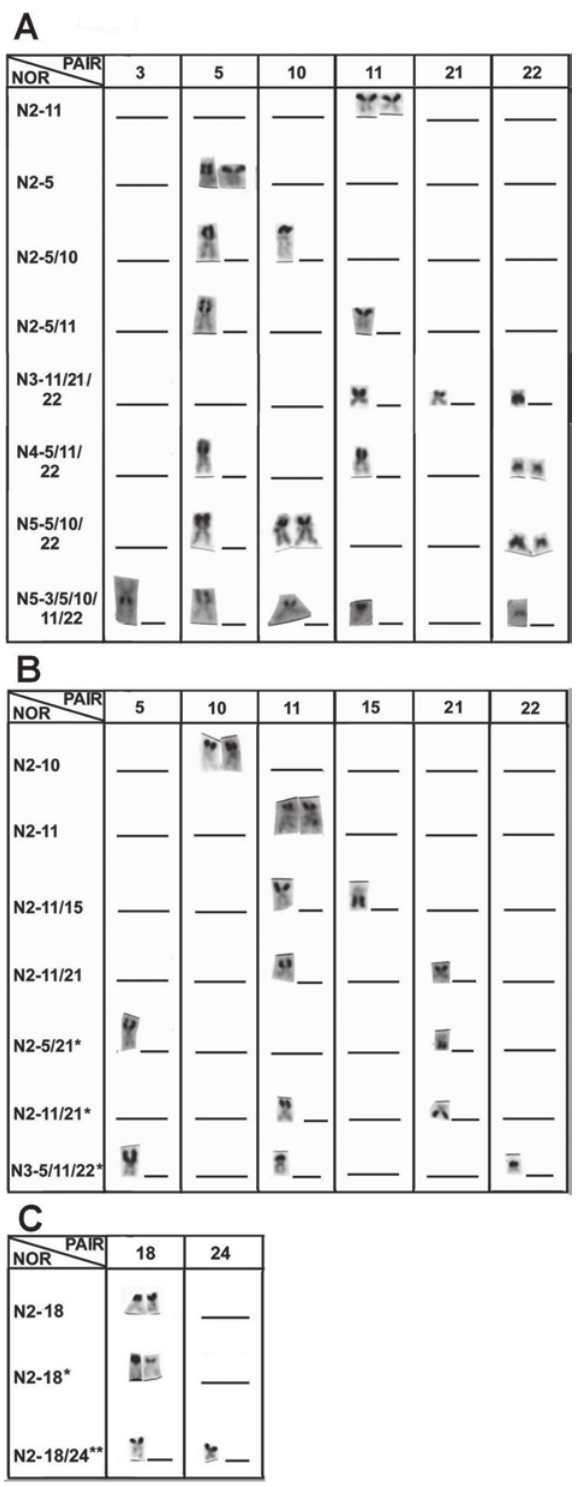
Fig. 4. NORs phenotypes (Nx-xx) corresponding to the num- bers of observed NORs and their karyotypic position (pair) seen in: (A) Symphysodon haraldi from Manacapuru; (B) S. aequifasciatus from Tefé, * represents cytotype 2; (C) S. dis- cus from Barcelos, * represents heteromorphic NOR, ** rep- resents cytotype